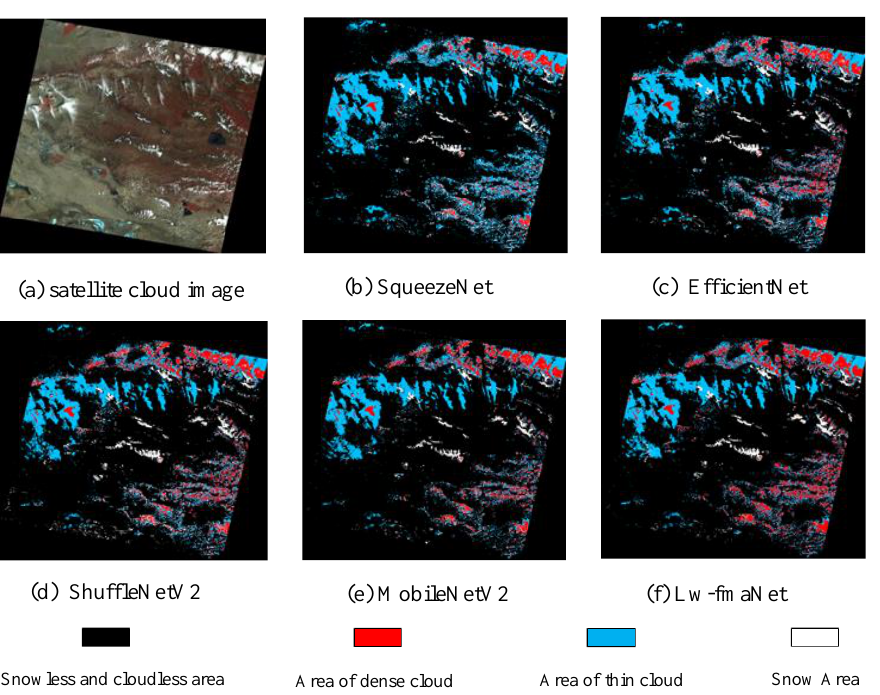
Figure 12. Generalization effect of cloud and snow recognition based on lightweight model.